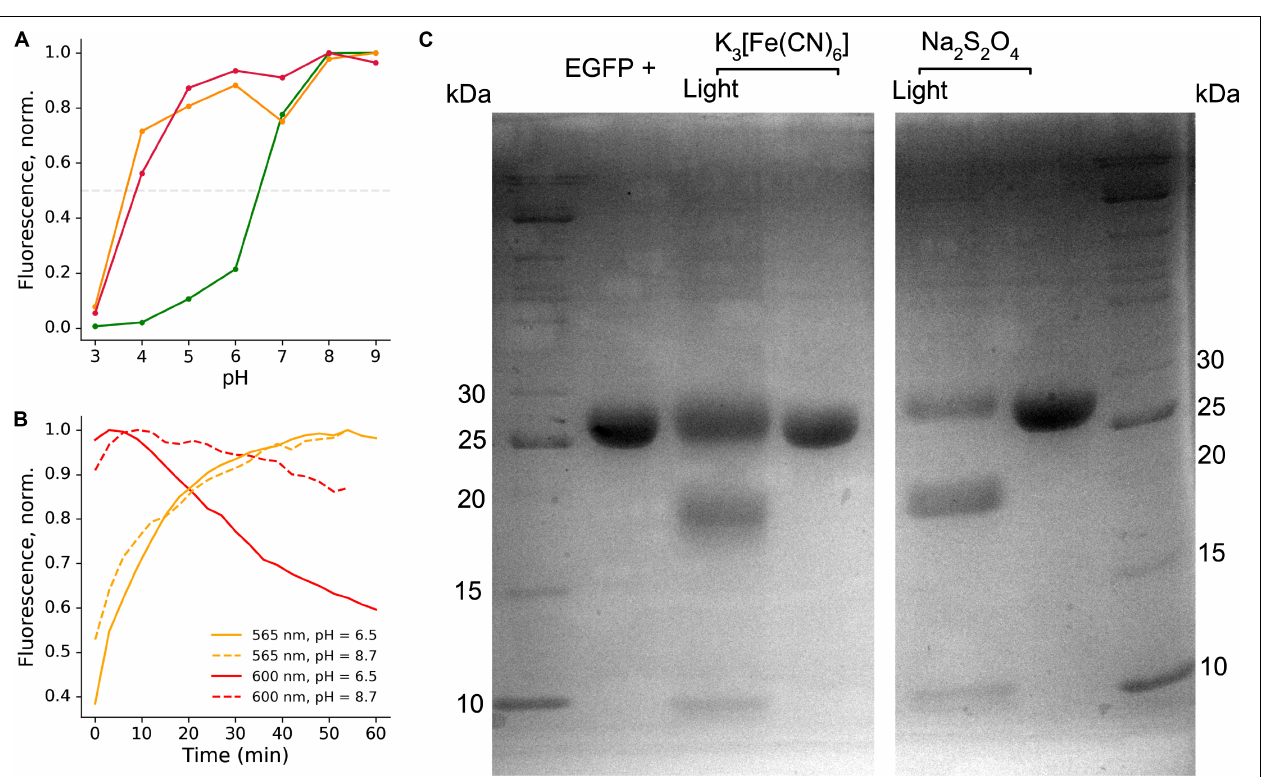
FIGURE 3 | Stability of the EGFP photoproducts. (A) Representative pH titration curve of the photoproducts in the presence of sodium dithionite; green line – emission at 525 nm, orange line – emission at 565 nm, red line – emission at 600 nm. (B) Representative time course of the light-independent stage of the photoconversion at different pH, showing better stability of the red-emitting form at high pH. (C) SDS-PAGE analysis of the light-irradiated and untreated EGFP samples in the presence of potassium ferricyanide or sodium dithionite.